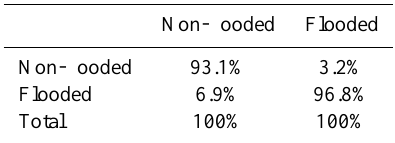
Table 3. Confusion matrix between the classification yielded by our algorithm using the COSMO-SkyMed images acquired on 10 January 2010 and 7 July 2009, and that produced by the histogram thresholding method (only the image of 10 January 2010). Columns represent the result obtained by applying our algorithm.